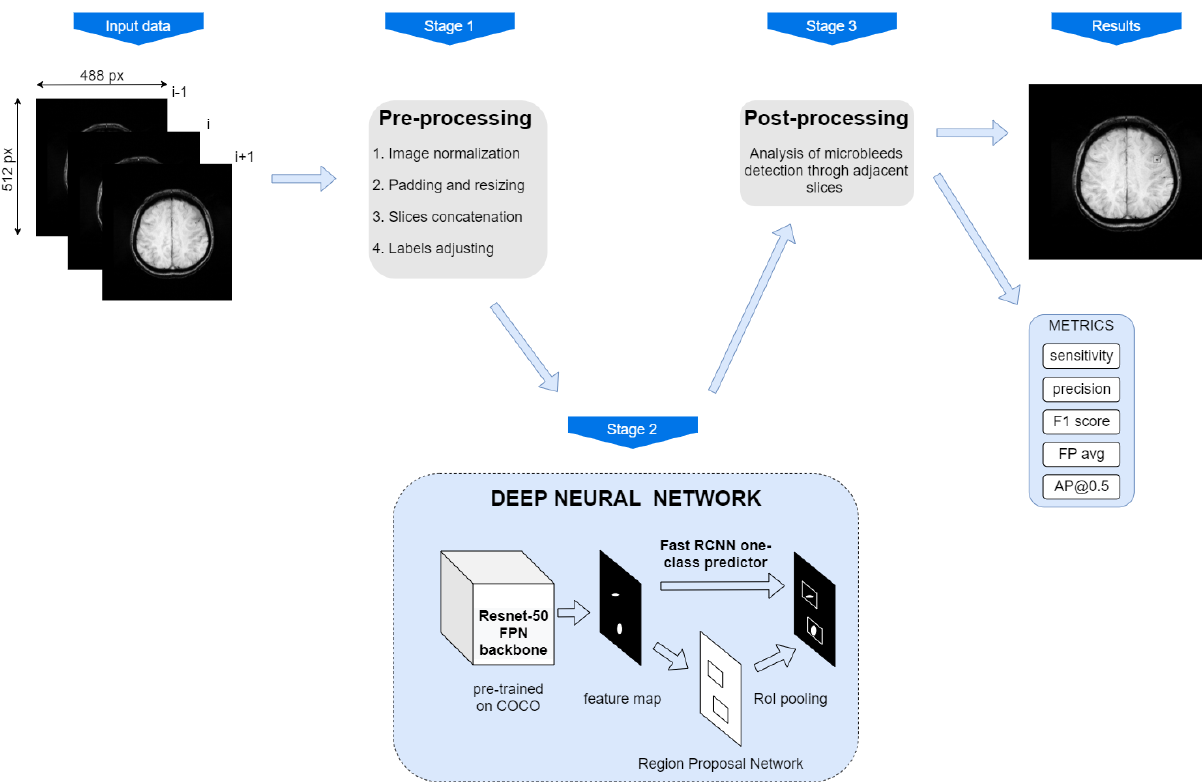
Figure 2. The pipeline of the proposed cerebral microbleeds detection system. The input dataset undergoes pre-processing including padding, resize, normalisation, slice concatenation and labelling correction. Next, it goes through a deep neural network model and all the predictions are checked in the post-processing stage. At the output we get a bounding box with a predicted microbleed with a confidence score supported by the specific metrics. Table 1. Summary of data